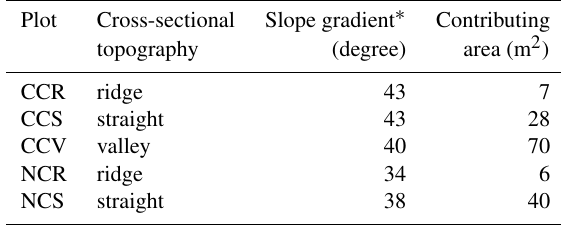
Table 1. Setting of monitoring